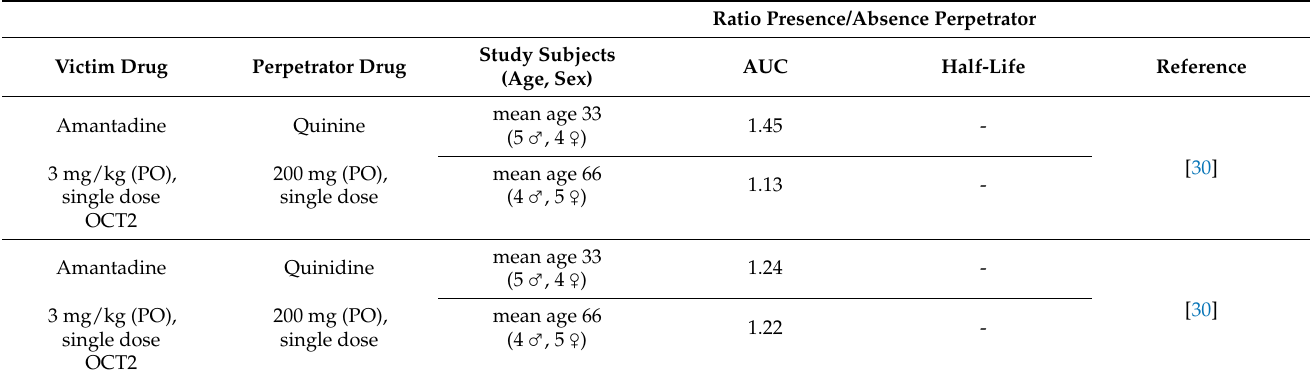
Table 4. Comparison of DDI magnitudes impacting renal elimination in elderly individuals relative to young